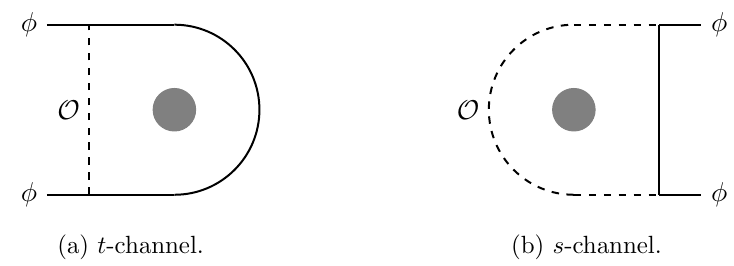
Figure 8. The t -channel sum over the asymptotic parts represented by the diagram on the left inverts to the s -channel process on the right. Accordingly, the inversion should produce poles for the [ OO ] m families. The diagram on the right can itself be deciphered by reading it from right to left; (cid:12)rst the external (cid:30) operators form [ (cid:30)(cid:30) ] n , which mixes with [ OO ] m via exchange of a (cid:30) , then the [ OO ] m receive expectation values proportional to b 1 .